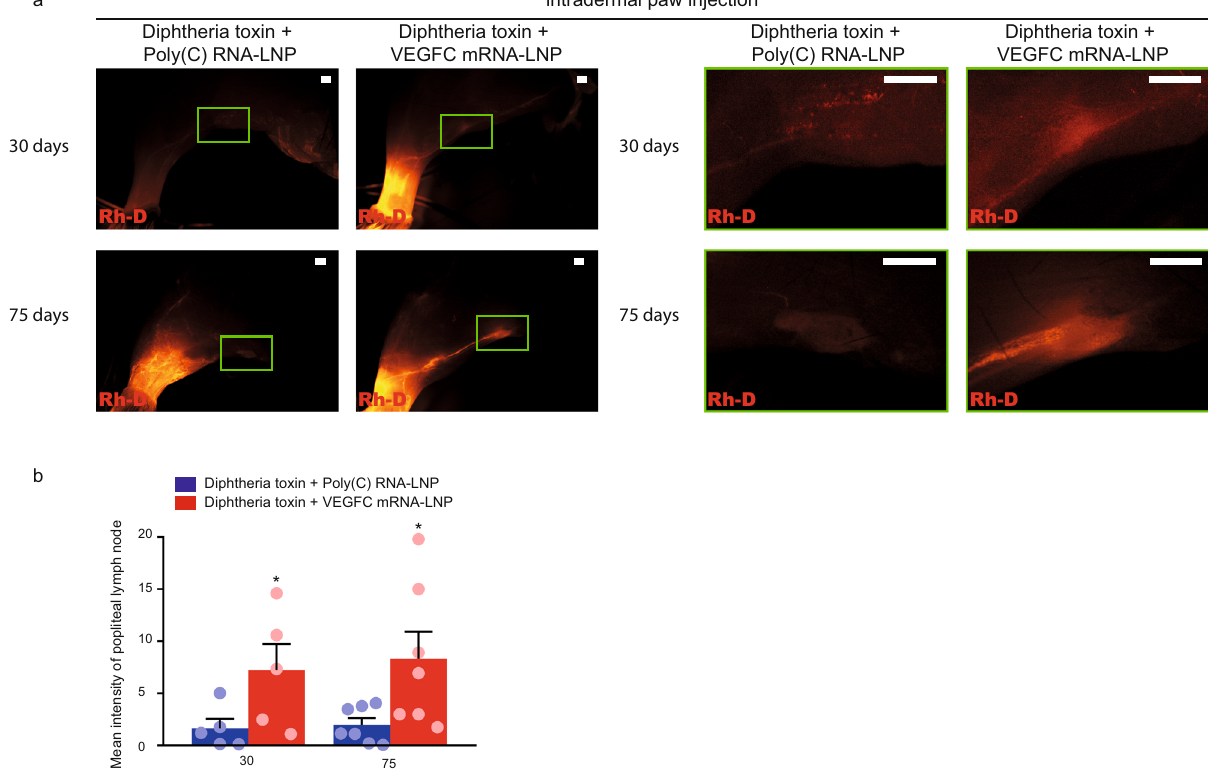
Fig. 10 VEGFC mRNA-LNP treatment restores lymphatic function in experimental lymphedema. a Monitoring active lymphatic function in the contralateral hind limbs of the same tamoxifen-treated Flt4-CreER T2 ; iDTR fl / fl mouse 30 or 75 days after the injection of Diphtheria toxin and 1 µ g of Poly (C) into one paw and Diphtheria toxin and 1 µ g of VEGFC mRNA-LNPs into another paw. Poly(C) or VEGFC mRNA-LNPs were injected 8 days after Diphtheria toxin treatment. 70 kDa Rh-D was injected into the paws and the transport of the molecule was monitored by fl uorescent microscopy 90 min post Rh-D administration. Representative images are shown of 5-7 mouse hind limbs in each group (bars, 1000 µ m). Green rectangles show the magni fi ed area which represent the area of popliteal lymph nodes. b Fluorescent intensity of popliteal lymph nodes of tamoxifen-treated Flt4-CreER T2 ; iDTR fl / fl mice 30 and 75 days after the injection of Diphtheria toxin and 1 µ g of Poly(C) into one paw and Diphtheria toxin and 1 µ g of VEGFC mRNA-LNPs into another paw. Poly(C) or VEGFC mRNA-LNPs were injected 8 days after Diphtheria toxin treatment. 70 kDa Rh-D was injected into the paws and the transport of the molecule was monitored by fl uorescent microscopy 90 min post Rh-D administration. Quantitative data are represented as mean and SEM in 5 – 7 popliteal lymph nodes in each group (two-tailed, paired T -test, P = 0.0425 after 30 days for 5 mice and P = 0.0373 after 75 days for 7 mice). Asterisks indicate P < 0.05 compared with